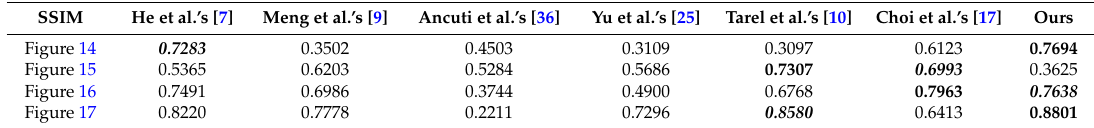
Table 1. Comparison of structural similarity (SSIM) for the dehazing results obtained via different methods.